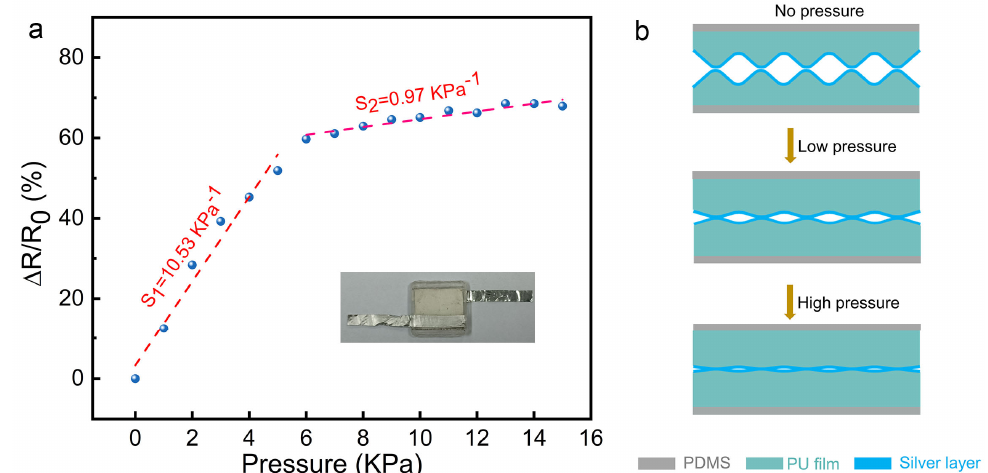
Figure 4. ( a ) Relative resistance change versus applied pressure on the flexible piezoresistive pressure sensor. Inset: a photo of the assembled pressure sensor. ( b ) The working mechanism of the fabricated piezoresistive sensor under loading pressure. Table 1. A Comparison of some piezoresistive pressure sensors reported recently with the proposed